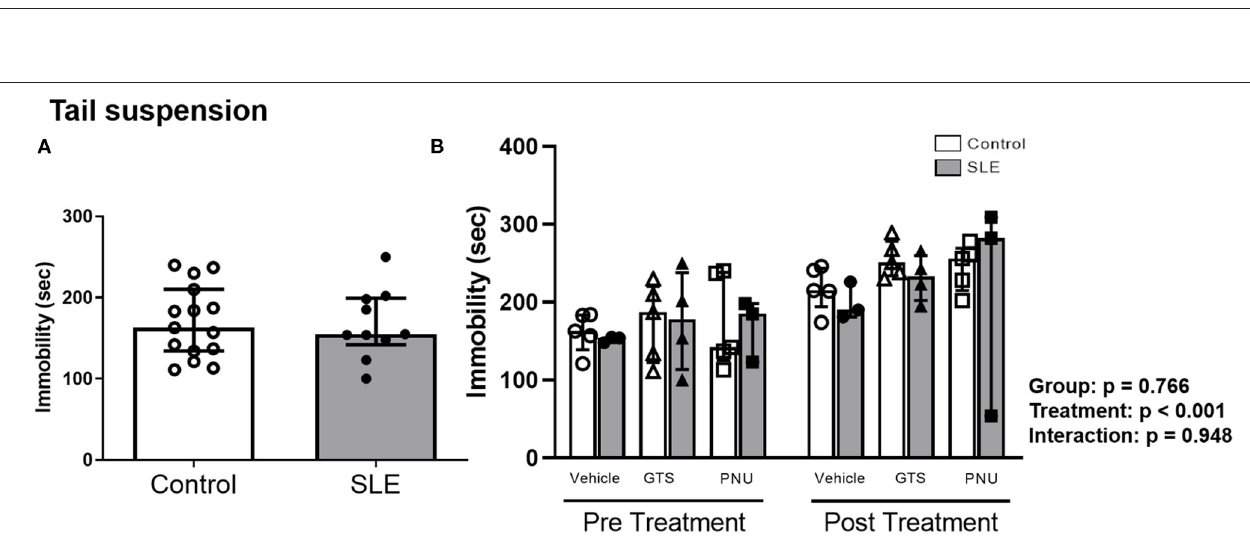
FIGURE 6 | Tail suspension test in control and SLE mice pre-treatment (A) and post-treatment with GTS-21 and PNU-120596 (B) . The pre-treatment data is a comparison between all control and all SLE mice at baseline. A t -test was used to determine significant differences between SLE and control mice pretreatment. There was not a difference in immobility during the suspension test between SLE mice and controls. A two-way ANOVA with repeated measures was used to determine differences between all groups post treatment ( B ; n = 3-5 per group). The results of each ANOVA appears on the graph.